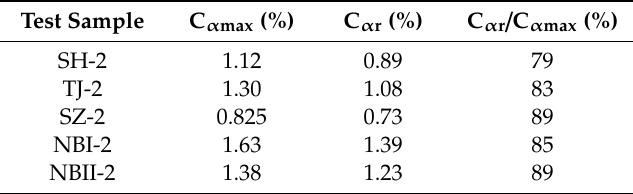
Table 9. A summary of C α max and C α r